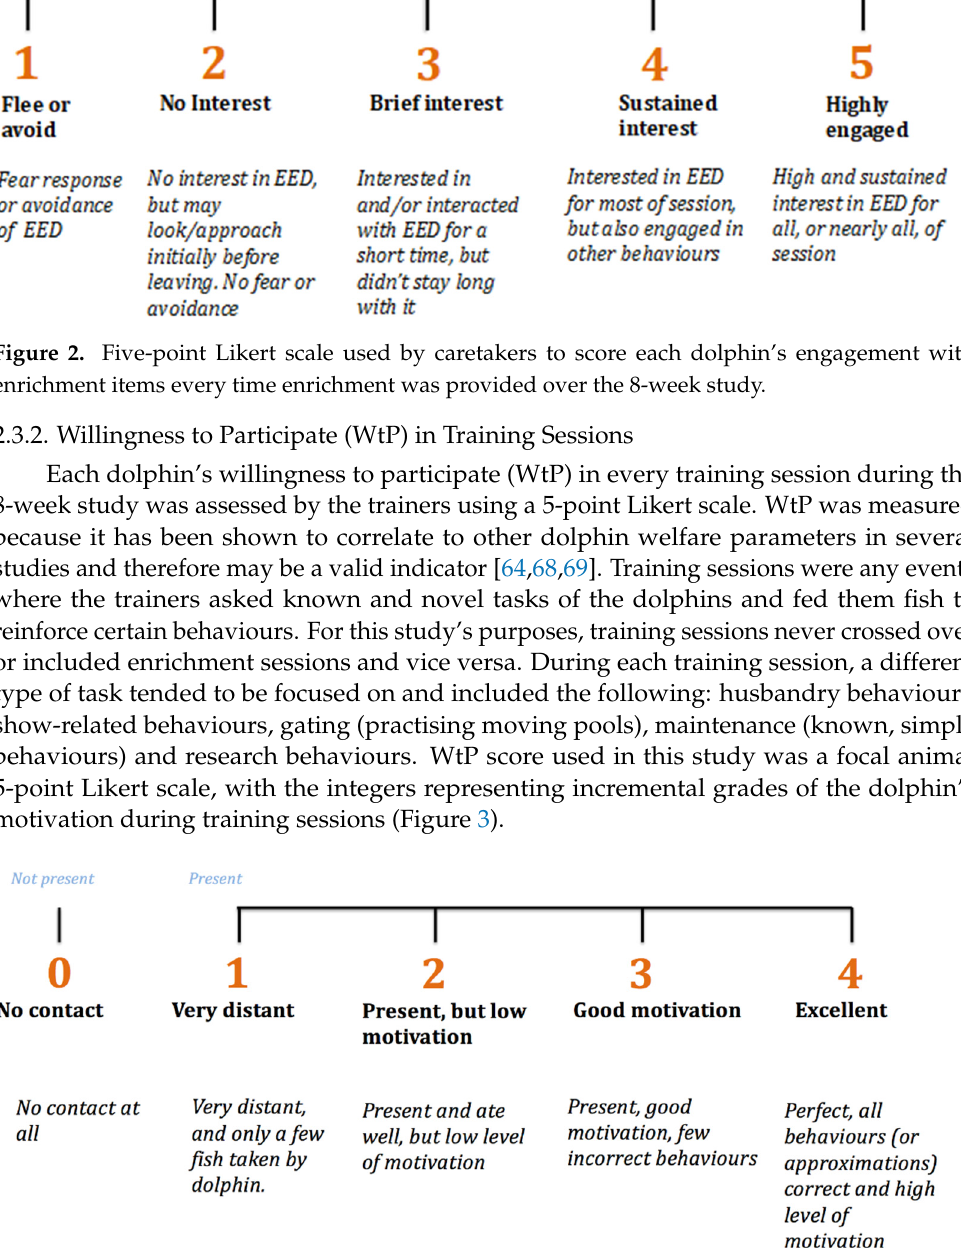
Table 2. Welfare-related bottlenose dolphin behaviours (with definitions and references showing link to welfare) included in the study’s ethogram for the behavioural observation protocol. Behaviour